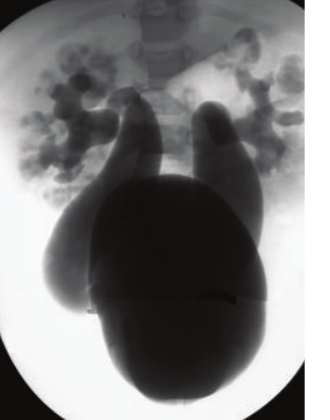
Figure 6: Procedure as CEVL components in a case of grade IV reflux in an infant girl. Voiding cystourethrogram (VCUG) show- ing Grade IV reflux in an 18 month old girl with recurrent fe- brile urine infection which breaks through prophylactic antiseptic administration. There is a family history or reflux. The family chose to repair reflux by endoscopic injection therapy. The CEVL method was used as is